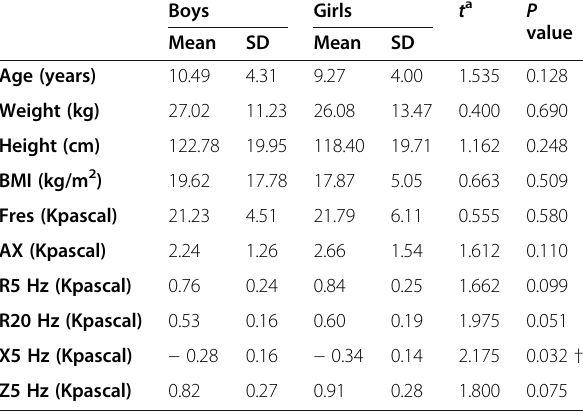
Table 2 Comparison between boys and girls regarding age, anthropometric measures, and IOS parameters